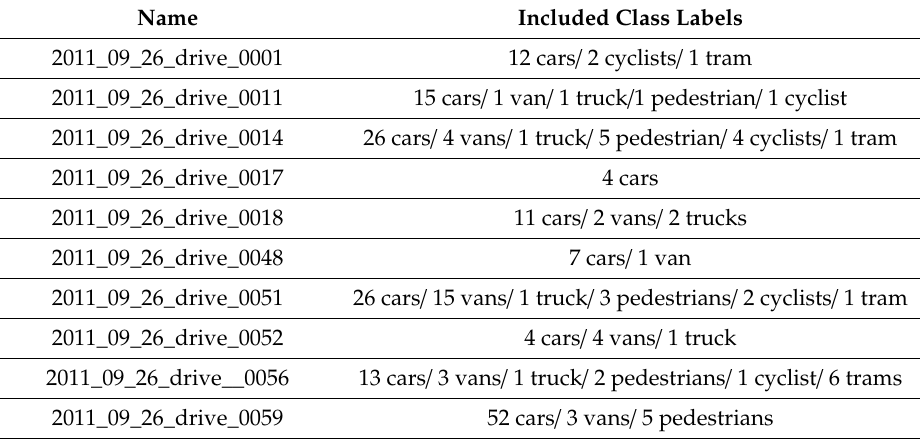
Table 1. Summary of KITTI dataset used.